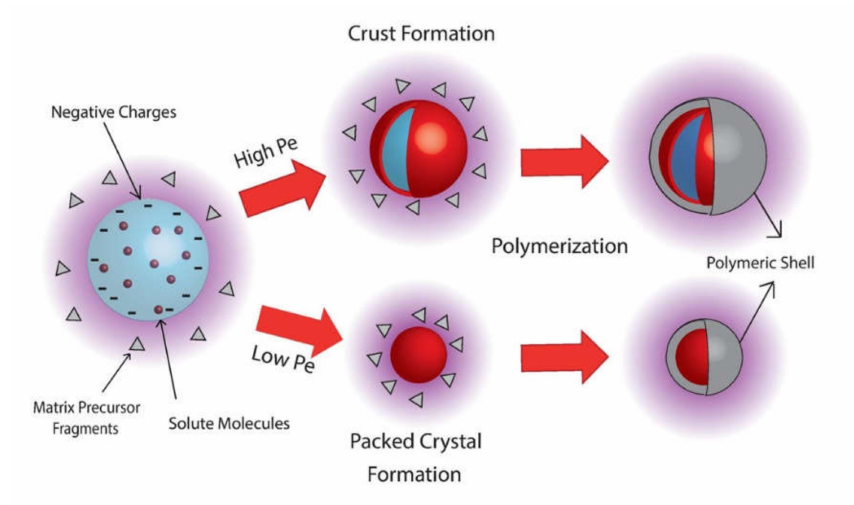
Figure 16. Scheme of the mechanism of nanocapsule formation in aerosol-assisted atmospheric pressure plasma. P e = K / D , where D is the mass di ff usivity of the particle / solute dispersed in the solvent, and K is the evaporation rate (supposed constant). Reprinted with permission from [75]. Copyright 2006 John Wiley & Sons,